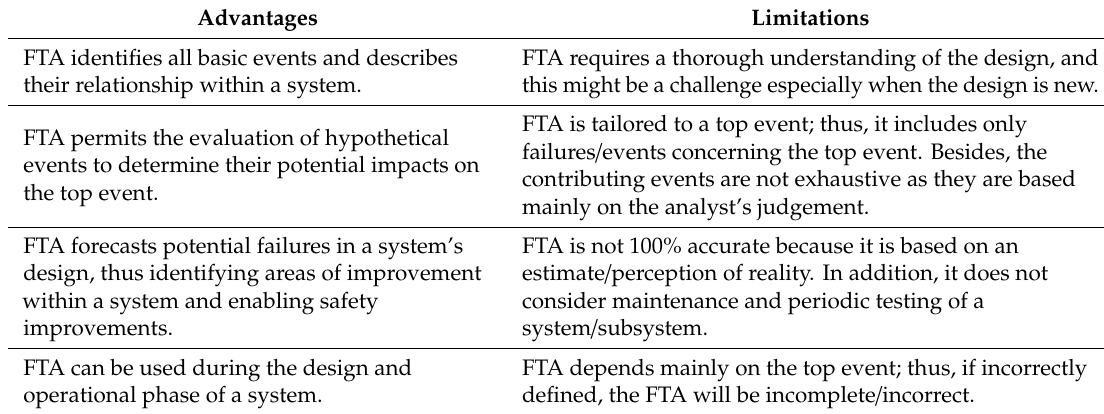
Table 3. Advantages and limitations of Fault Tree Analysis